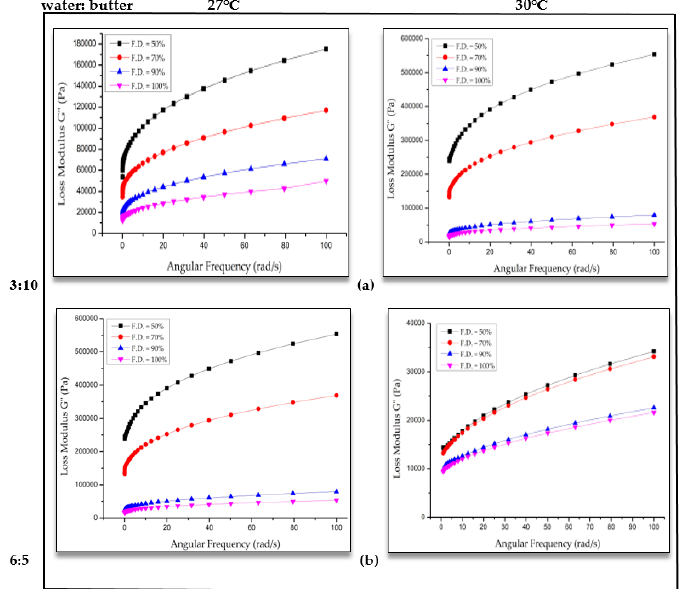
Figure 4. Loss modulus (G’’) versus angular frequency of dough at different water ratios: ( a ) 3:10 and ( b ) 6:5 at 27 °C and 30 °C.